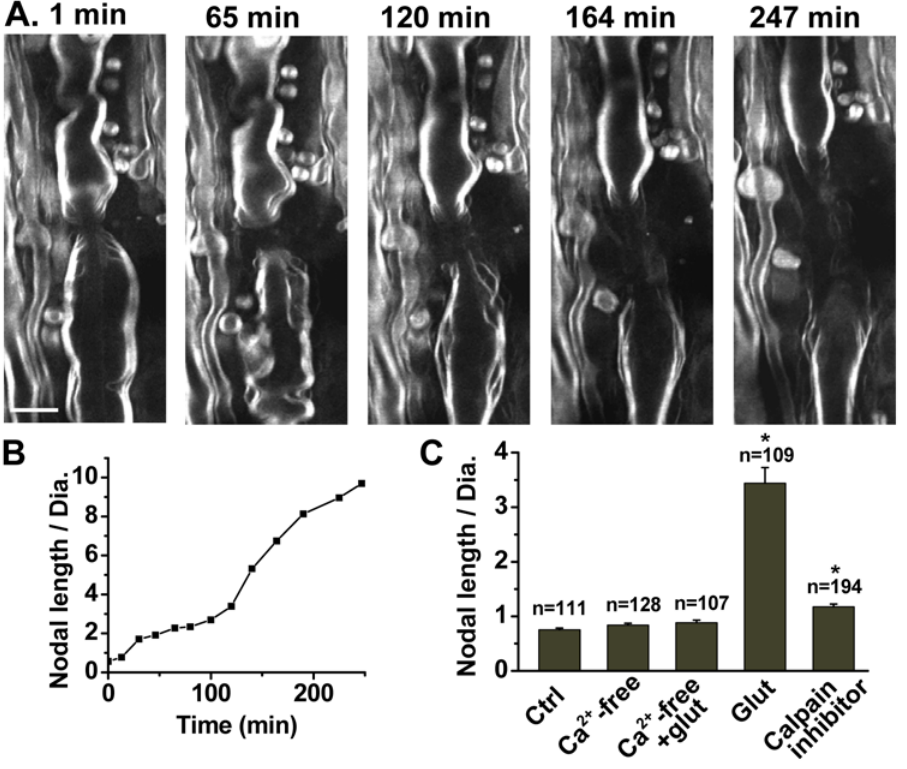
Figure 4. Ca 2 + influx and calpain activation are involved in glutamate-induced paranodal myelin damage. (A) Time-lapse CARS images of paranodal myelin after different periods of treatment with 250 m g/mL Ca 2 + ionophore A23187. Bar=10 m m. (B) Increase of the nodal length-to- diameter ratio with time for the node in (A). (C) Statistical analysis of ratios of nodal length to nodal diameter under five different conditions. ‘Ctrl’ represents samples incubated in Krebs’ solution. ‘Ca 2 + -free’ represents samples incubated in Ca 2 + -free Krebs’ solution. ‘Ca 2 + -free + Glut’ represents samples exposed to 1 mM glutamate in Ca 2 + -free Krebs’ solution. ‘Glut’ represents samples exposed to 1 mM glutamate in normal Krebs’ solution. ‘Calpain inhibitor’ represents samples exposed to calpain inhibitor III MDL 28170 and glutamate together. Five groups of samples were exposed to the different conditions for 5 h. * p , 0.001 between the ‘Glut’ group and the ‘Ctrl’ group, and between the ‘Calpain inhibitor’ group and the ‘Glut’